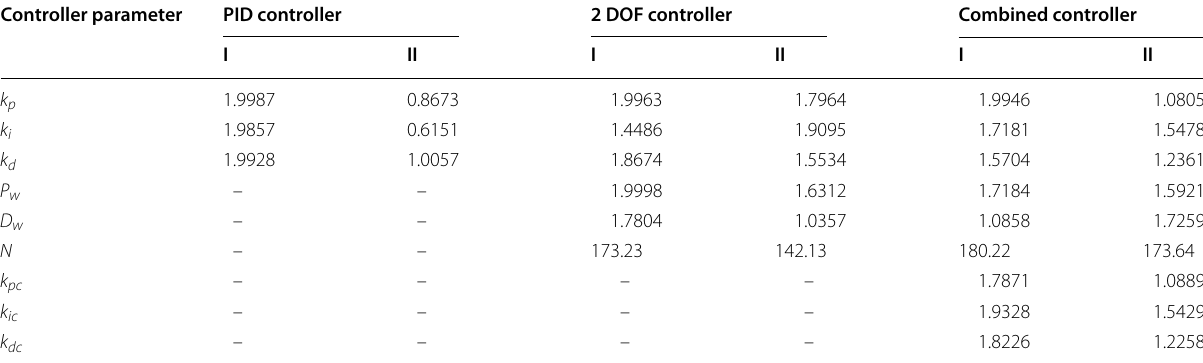
Table 1 CRSOA tuned controller parameters of the system without wind penetration Controller parameter